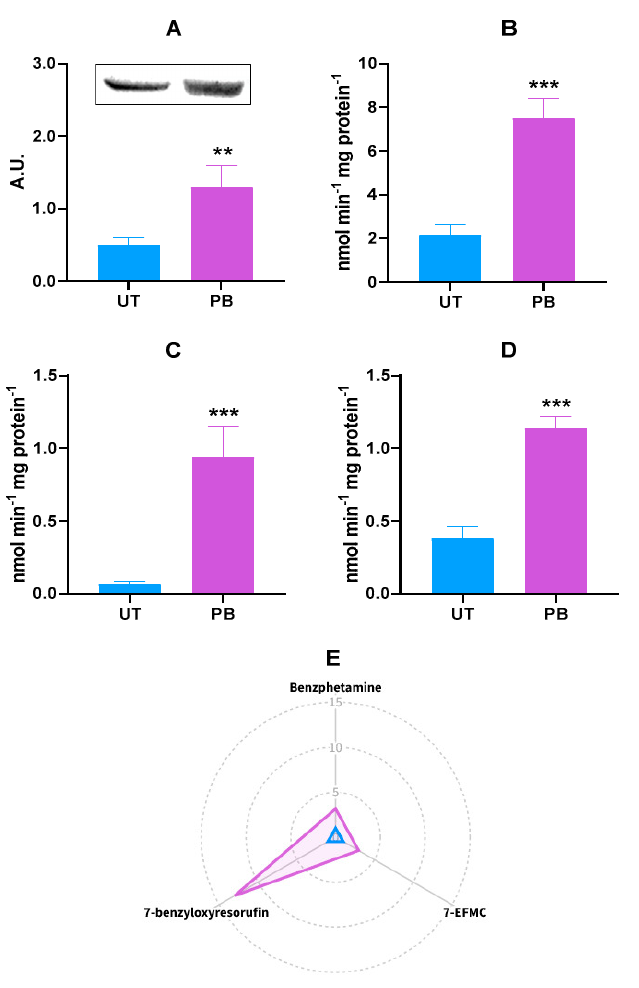
Figure 2. Hepatic CYP2B22 protein expression ( A ) and in vitro metabolism of CYP2B22 marker sub- strates benzphetamine ( N -demethylation; ( B )), 7-EFMC ( O -demethylation; ( C )), 7-benzyloxyresorufin ( O -debenzylation; ( D )) in untreated control (UT, n = 3) and phenobarbital-treated (PB, n = 4) cattle. In the radar plot ( E ), data are expressed in arbitrary units (A.U.), and a value of 1 was attributed to UT cattle. In the bar charts, data are expressed as arithmetic means ± SD. 7-EFMC: 7-ethoxy-4-trifluoromethylcoumarin. ** p < 0.01; *** p < 0.001 (unpaired t -test).